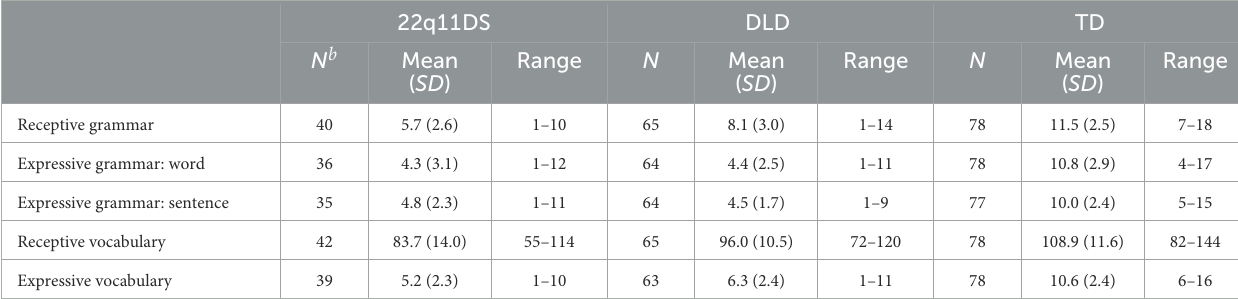
TABLE 3 Performance of the three groups of preschool children on the standardized language measures a